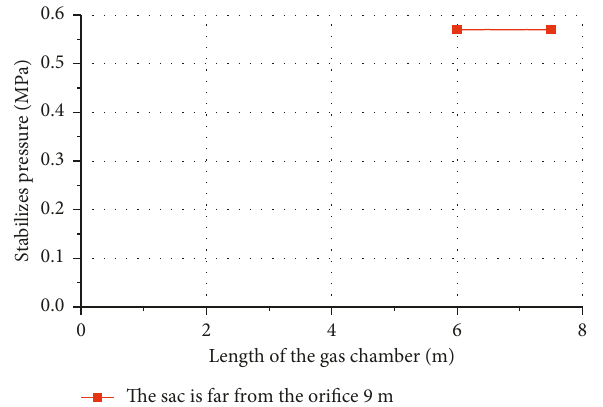
Figure 16: Effect of air chamber length on stable pressure when the sealing hole segment is 9m from the orifice.